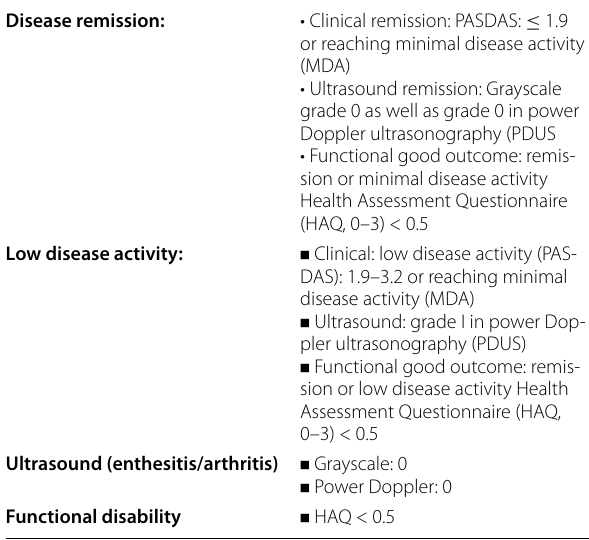
Table 3 Definitions and cut‑off points of disease remission and low disease activity [20–22] Disease